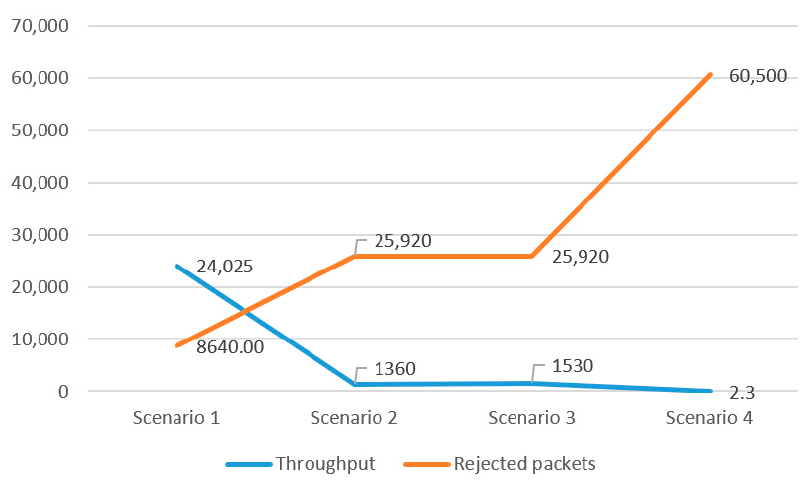
Figure 12. Correlation of throughput versus the number of rejected packets.